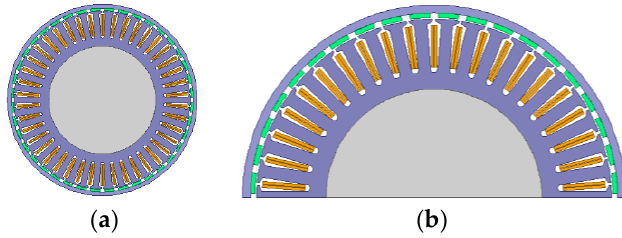
Figure 12. Whole model ( a ) and simplified model ( b ) of outer rotor brushless DC motor.